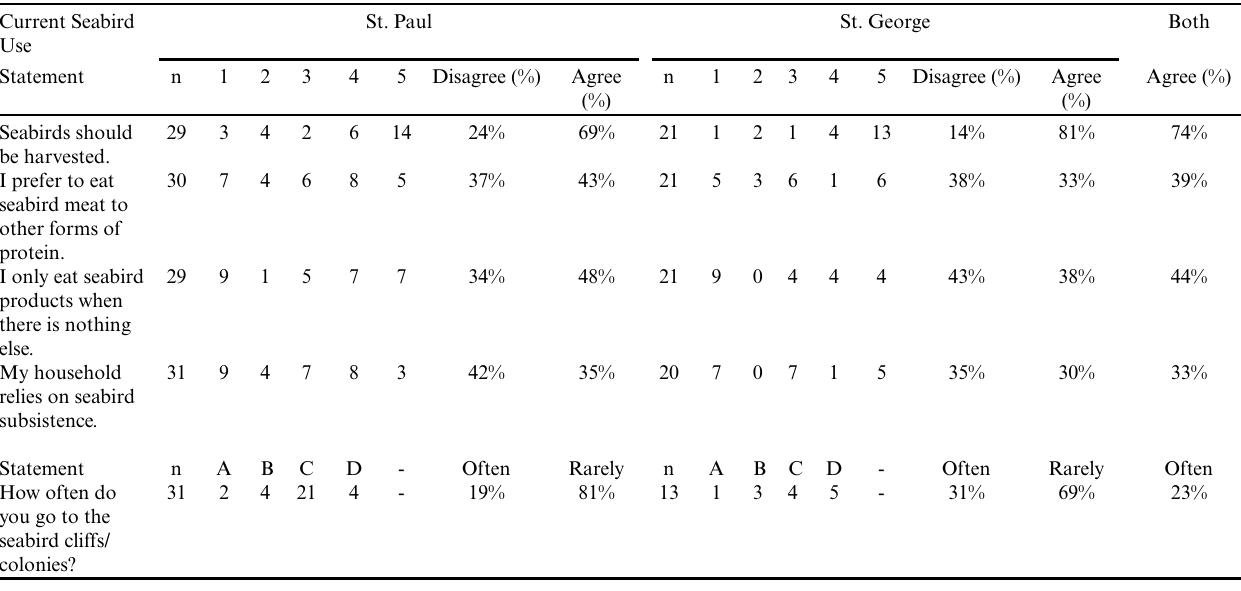
Table 3 . Survey responses to statements assessing current seabird use and preferences. For each island the sample size (n) responding to each question is given, along with the responses broken down according to the Likert scale: 1 = Disagree; 2 = Somewhat Disagree; 3 = Neither; 4 = Somewhat Agree; and 5 = Agree. The last statement was not done on the Likert agreement scale: A = 2+ times/week; B = 2+ times/month; C = 2+ times/year; D = never. For each statement the percent of responses agreeing and disagreeing (or visiting often and rarely) is provided for each community. The last column indicates the percentage of responses in agreement with the statement in the entire